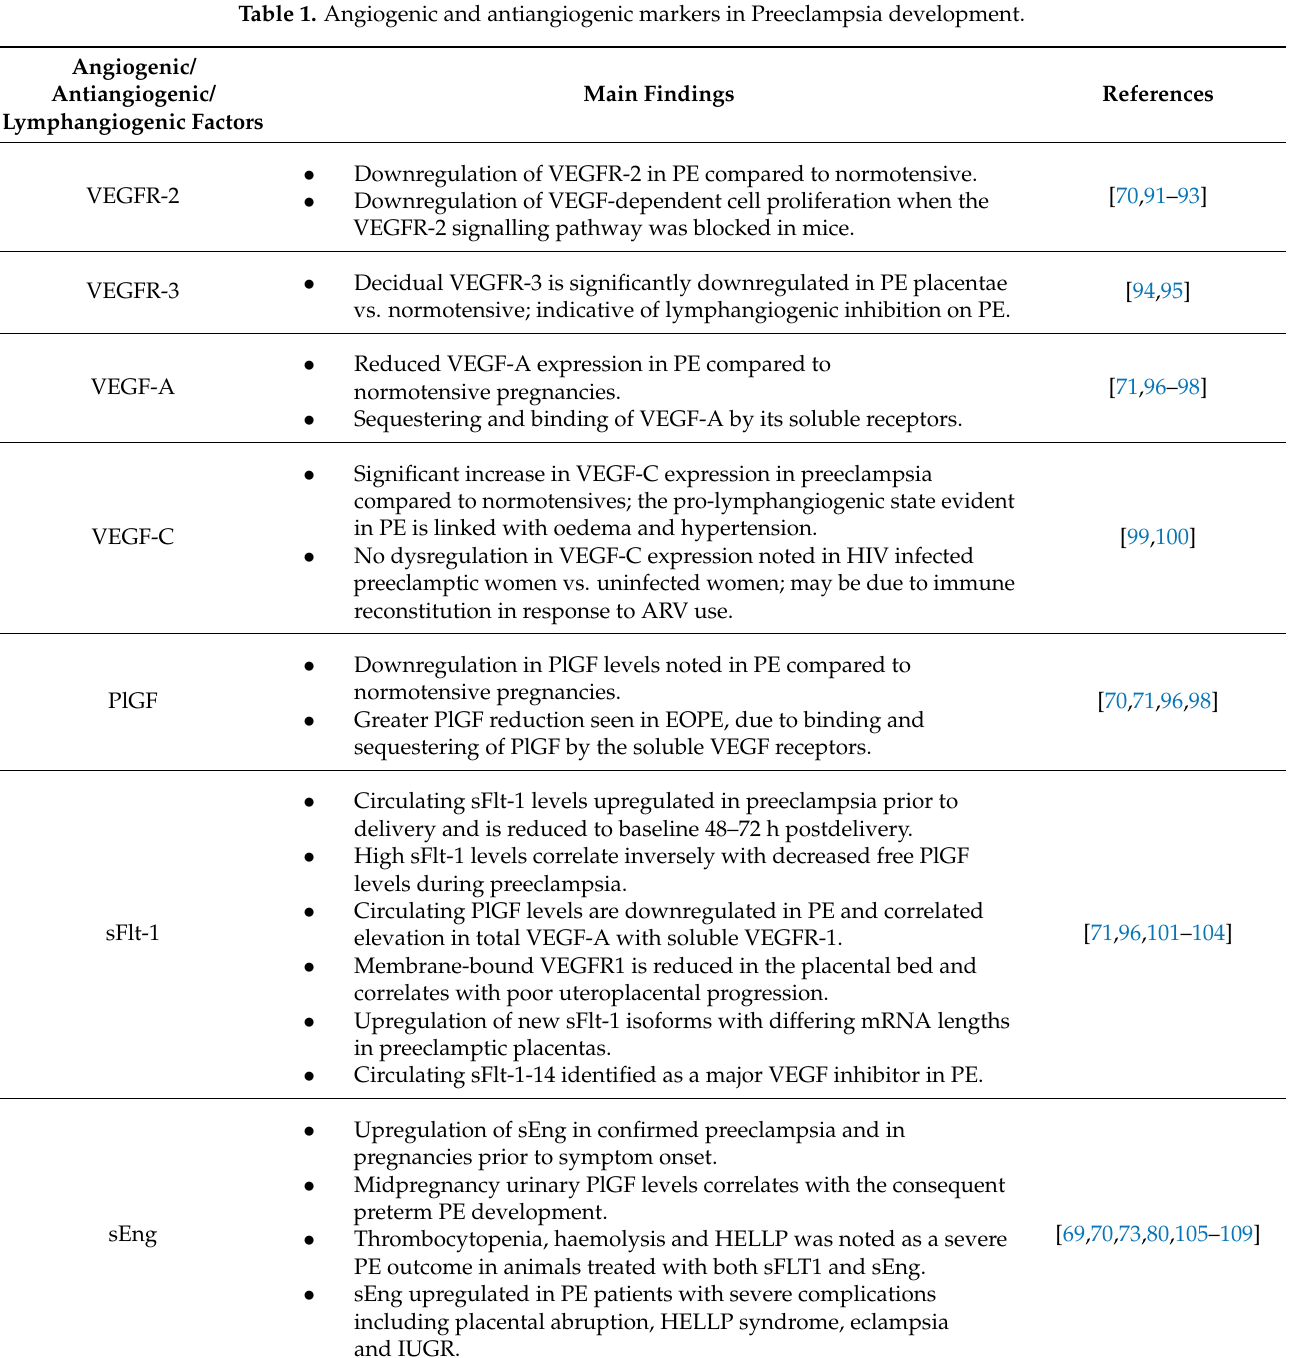
Table 1. Angiogenic and antiangiogenic markers in Preeclampsia